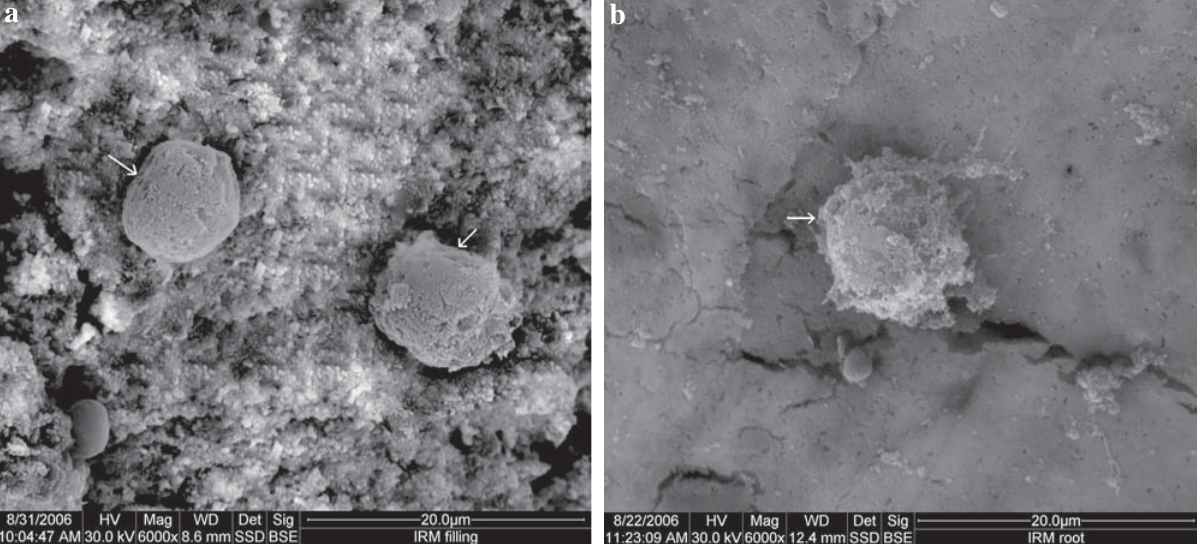
Figure 5 (cid:7)(cid:12)(cid:31)(cid:21)(cid:15)(cid:6)(cid:6)(cid:5)(cid:6)(cid:13)(cid:12)(cid:3)(cid:14)(cid:3)(cid:21)(cid:17)(cid:16)(cid:9)(cid:6)(cid:12)(cid:8)(cid:5)(cid:21)(cid:16)(cid:9)(cid:4)(cid:21)(cid:9)(cid:22)(cid:3)(cid:12)(cid:24)(cid:31)!"(cid:29)(cid:12)(cid:8)(cid:5)(cid:21)(cid:16)(cid:9)(cid:13)(cid:16)(cid:15)(cid:22)(cid:18)(cid:12)(cid:9)(cid:23)(cid:12)>(cid:2)"%(cid:12)(cid:24)(cid:15)(cid:29)(cid:12)(cid:8)(cid:15)(cid:17)(cid:3)(cid:16)(cid:5)(cid:15)(cid:14)(cid:12)(cid:4)(cid:19)(cid:16)(cid:23)(cid:15)(cid:21)(cid:3)(cid:12)(cid:24)(cid:9)(cid:16)(cid:5)(cid:13)(cid:5)(cid:6)(cid:15)(cid:14)(cid:12)(cid:8)(cid:15)(cid:13)(cid:6)(cid:5)(cid:11)(cid:21)(cid:15)(cid:17)(cid:5)(cid:9)(cid:6)(cid:12)’(cid:26)(cid:27)(cid:27)(cid:27)(cid:28)(cid:29)*(cid:12)(cid:24)/(cid:29)(cid:12) Geristore (cid:19)(cid:20)(cid:11)(cid:7)(cid:16)(cid:11)(cid:3)(cid:3)(cid:13)(cid:7)(cid:24)(cid:5)(cid:7)(cid:10)(cid:20)(cid:11)(cid:7)(cid:13)(cid:21)(cid:12)#(cid:9)(cid:16)(cid:11)(cid:7)(cid:24)#(cid:7)*(cid:11)(cid:12)(cid:4)(cid:13)(cid:10)(cid:24)(cid:12)(cid:11)(cid:7)(cid:8)(cid:9)(cid:10)(cid:11)(cid:12)(cid:4)(cid:9)(cid:3)(cid:7) were spindle shaped and well attached, with (cid:3)(cid:9)(cid:8)(cid:11)(cid:3)(cid:3)(cid:4)(cid:28)(cid:24)(cid:22)(cid:4)(cid:9)(cid:7) (cid:9)(cid:5)(cid:22)(cid:7) (cid:2)(cid:3)(cid:24)(cid:28)(cid:24)(cid:22)(cid:4)(cid:9)(cid:29)(cid:7) (cid:10)(cid:20)(cid:21)(cid:13)(cid:7) (cid:12)(cid:11)/(cid:11)(cid:16)(cid:10)(cid:4)(cid:5)(cid:6)(cid:7) (cid:6)(cid:24)(cid:24)(cid:22)(cid:7) attachment to the material. Root surfaces did not show differences from the material surfaces, (cid:20)(cid:9)(cid:17)(cid:4)(cid:5)(cid:6)(cid:7)(cid:10)(cid:20)(cid:11)(cid:7)(cid:13)(cid:9)(cid:8)(cid:11)(cid:7)(cid:16)(cid:11)(cid:3)(cid:3)(cid:7)(cid:16)(cid:24)(cid:5)(cid:2)(cid:6)(cid:21)(cid:12)(cid:9)(cid:10)(cid:4)(cid:24)(cid:5)(cid:7)(cid:9)(cid:5)(cid:22)(cid:7)(cid:9)(cid:3)(cid:8)(cid:24)(cid:13)(cid:10)(cid:7)(cid:10)(cid:20)(cid:11)(cid:7) same cellular density, when viewed at the same (cid:8)(cid:9)(cid:6)(cid:5)(cid:4)(cid:2)(cid:16)(cid:9)(cid:10)(cid:4)(cid:24)(cid:5)(cid:7)^0(cid:4)(cid:6)(cid:21)(cid:12)(cid:11)(cid:7)%J& IRM The IRM material surface showed round cells with rough surfaces and numerous vacuoles and surface depressions. The root surfaces